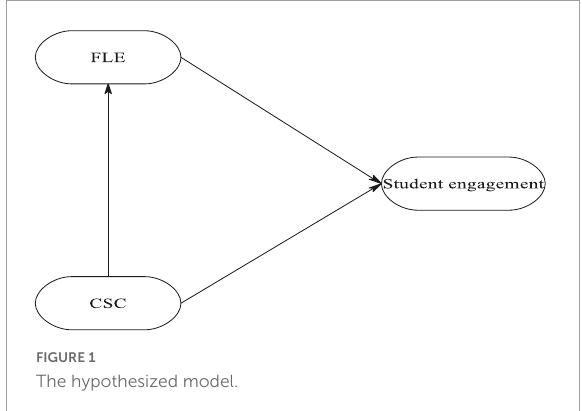
FIGURE1 The hypothesized